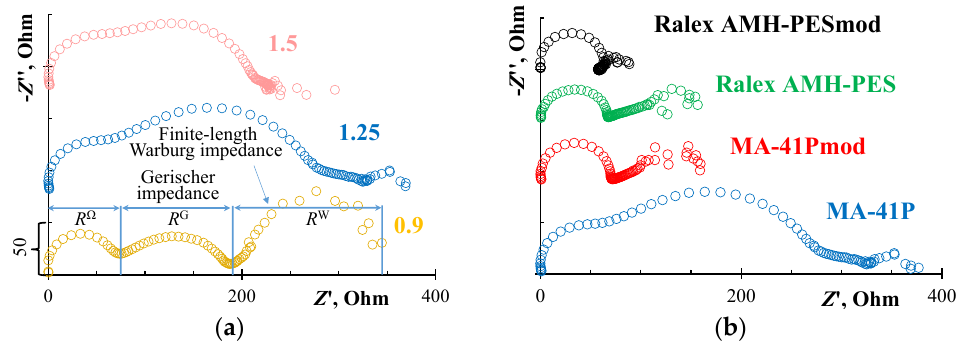
Figure 7. Electrochemical impedance spectra of MA-41P ( a ) at different values of biased direct current (0.9, 1.25, 1.5 i lim ) and spectra of MA-41P, MA-41Pmod, Ralex AMH-PES, and Ralex AMH-PESmod at 1.25 i lim ( b ).